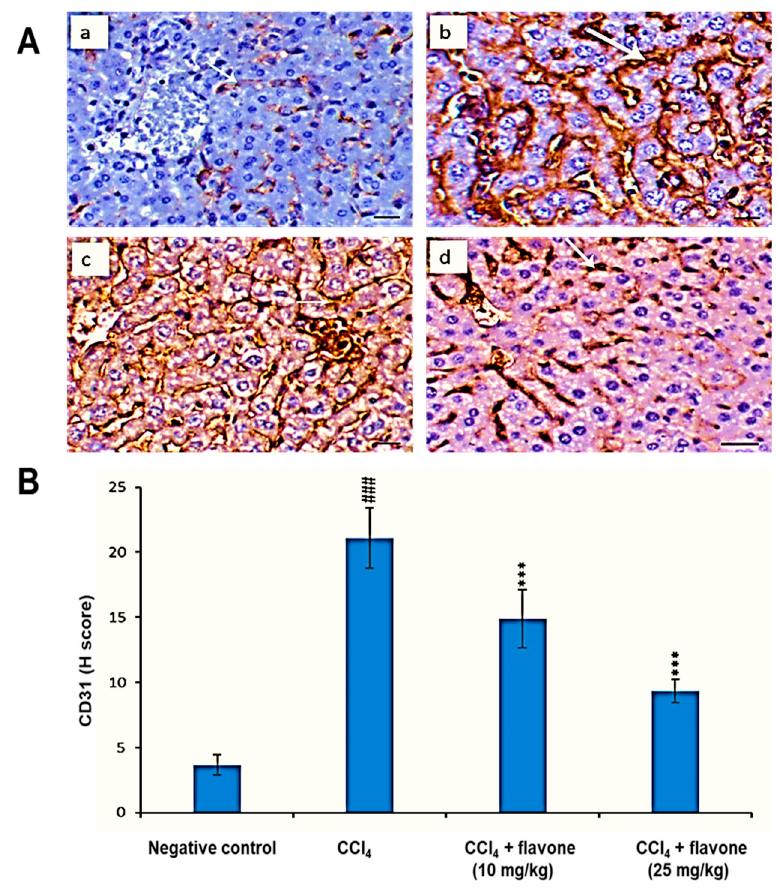
Figure 8. Effect of treatment with the flavone on the CD31 protein level in liver tissues. A : Representative liver immunohistochemical graphs (a: negative control group, b: carbon tetrachloride (CCl 4 ) group, c: CCl 4 + flavone (10 mg/kg) group, d: CCl 4 + flavone (25 mg/kg) group); ( a ) showed a noticeable expression of CD31 immunostaining in the liver tissues (arrow). ( b ) presented marked increase in CD31 expression within the liver tissues (arrow). ( c ) displayed mild to moderate decrease of CD31 expression in the liver tissues (arrow). ( d ) illustrated an obvious decrease in CD31 expression within the liver tissues (arrow). Scale bar = 100 µm. B : Statistical analysis of CD31 H-score. Data are expressed as mean ± SD. Significantly ( ### p < 0.001) different to negative control group. Significantly (*** p < 0.001) different to the CCl 4 group.